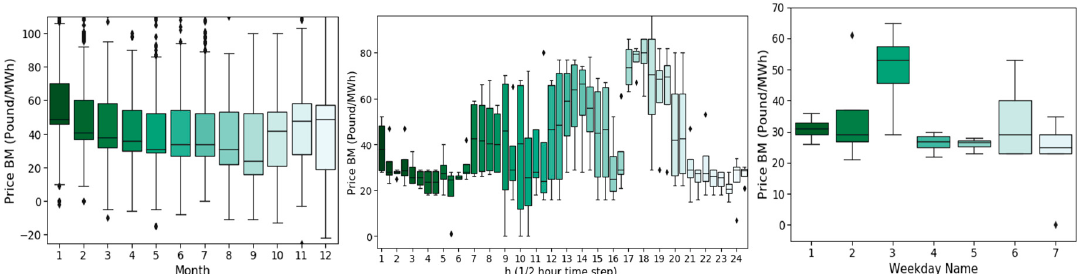
Figure 3. Boxplots of yearly ( left ), daily ( center ) and weekly ( right ) cycles of prices.